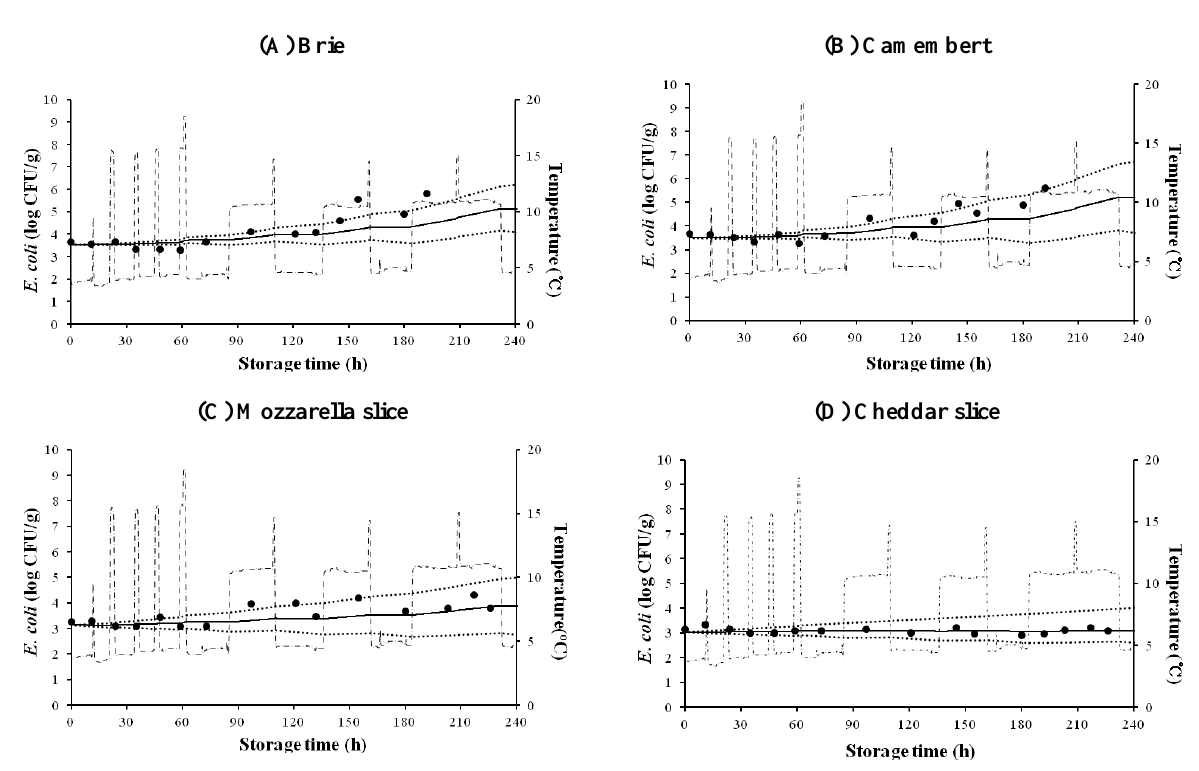
Figure 3. Predicted Escherichia coli growth on Brie cheese (A), Camembert cheese (B), Mozzarella slice cheese (C), and Cheddar slice cheese (D) under dynamic temperature condition. ●, observed data, —, predicted line, ·······, 95% confidence interval, - ∙ -,